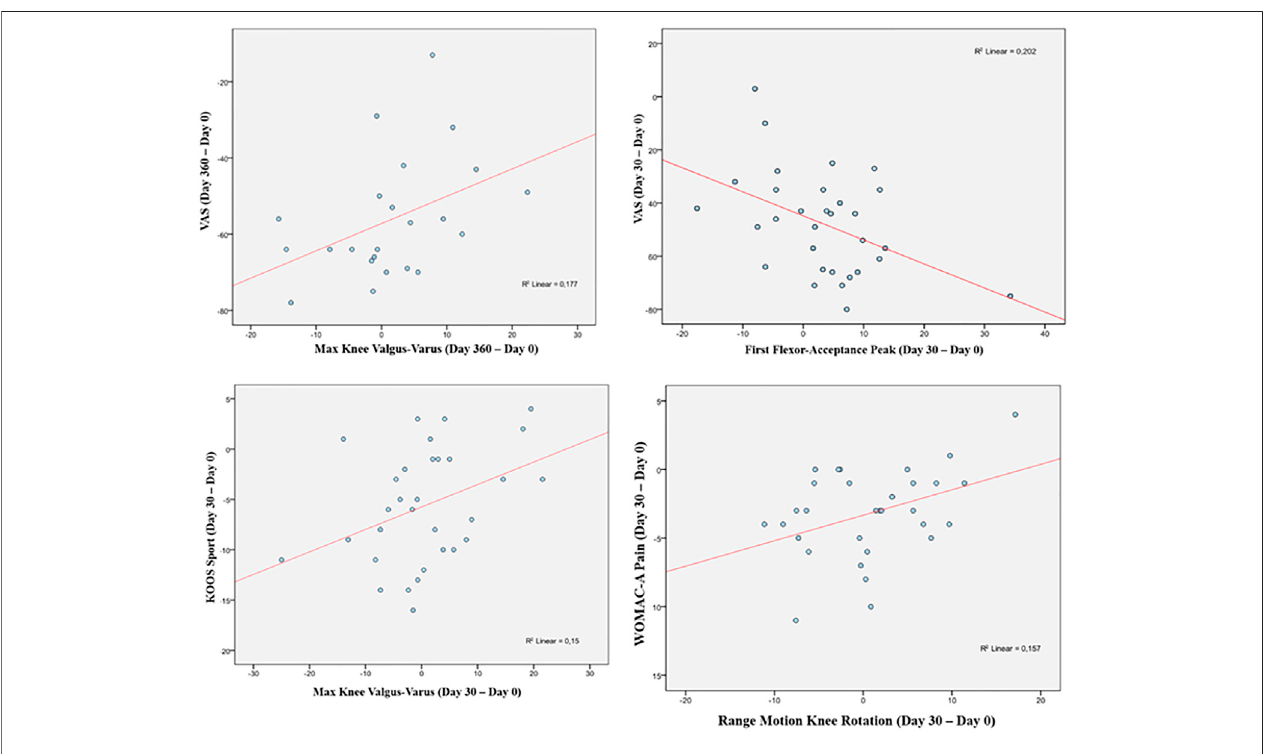
FIGURE 5 | Correlation analysis.